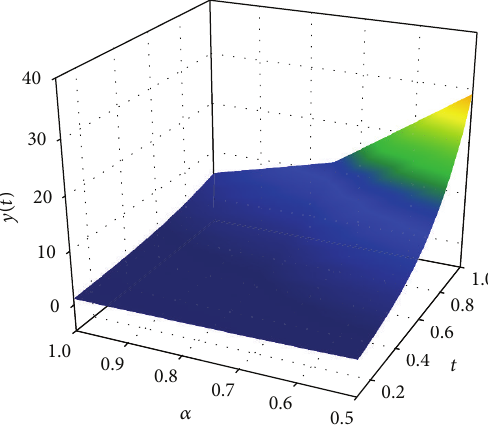
Figure 4: Numerical results of Example 2 by LWM for different values of 𝛼 .